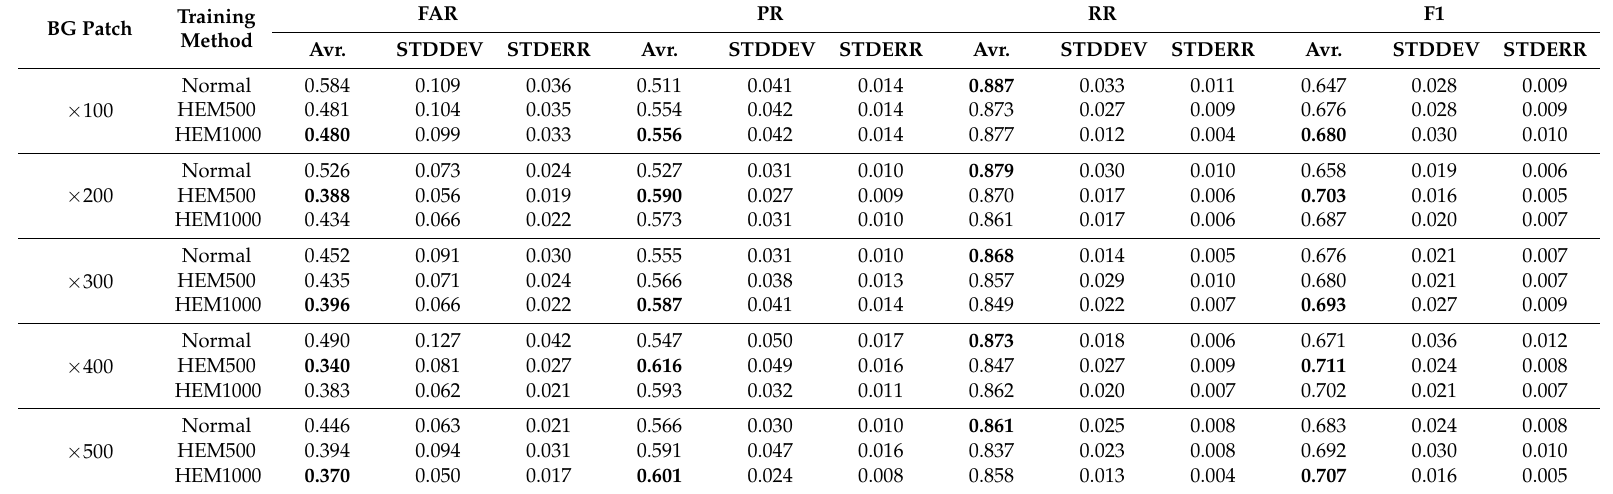
Table 4. Statistics of all quantitative measures. Here we emphasized the best accuracy among methods in bold